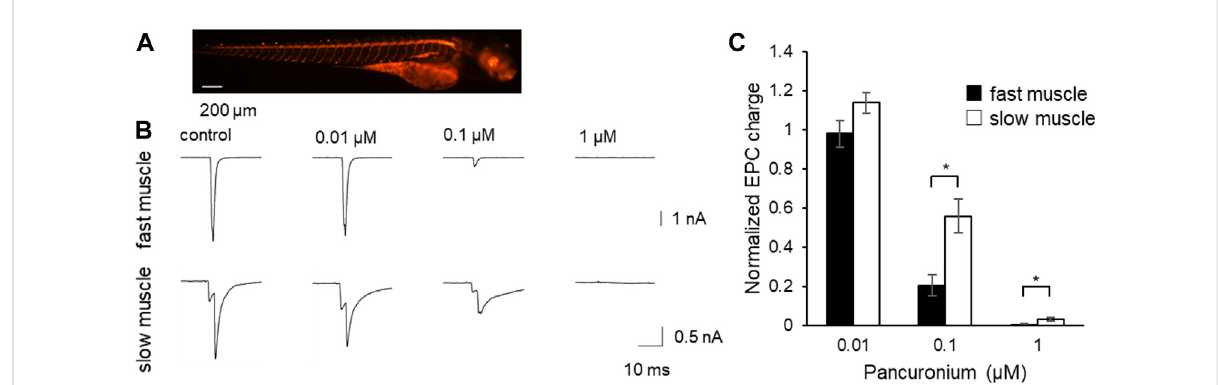
The effect of pancuronium on end-plate currents in fast and slow muscle fi bers. (A) Fluorescent image of 4 dpf Tg (hb9:tTAad, TRE:ChRFR- TagRFP) zebra fi sh. Motor neurons speci fi cally expressed channelrhodopsin fused with TagRFP. (B) Representative current traces from fast (top) and slow (bottom) muscle fi bers in response to the light stimulation in the presence of pancuronium, whose concentration in the solution is indicated above the traces. Note some of the traces have notches, which result from the non-overlapping time course of inputs from multiple motor